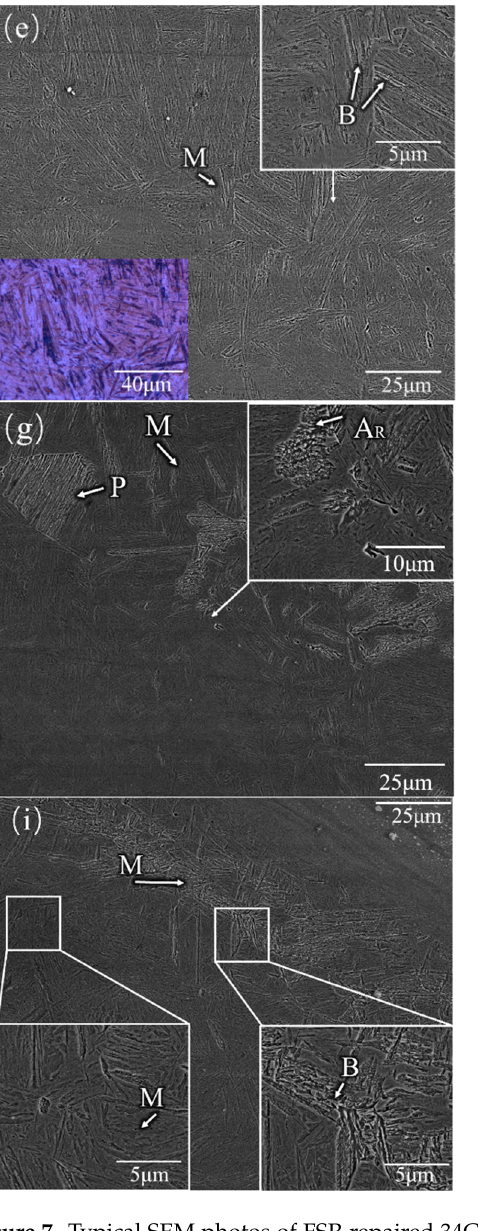
Figure 7. Typical SEM photos of FSP-repaired 34CrNiMo6 shown in Figure 5 (small box for partial enlargement): ( a – c ) zones A1–A3; ( d – f ) zones B1–B3; ( g – i ) zones C1–C3; ( j ) substrate. The color photos are optical microscope (OM) photos (A R : Retained austenite; M: Martensite; B: Bainite; P: Pearlite).